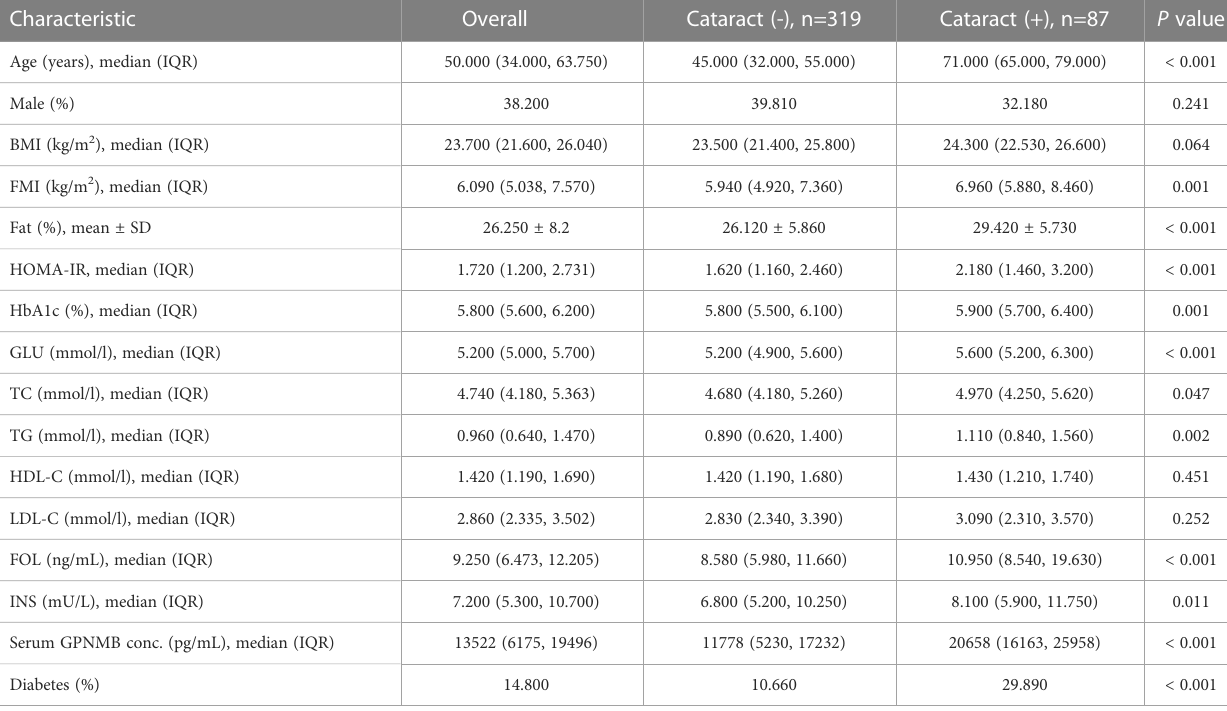
TABLE 2 Clinical and biochemical characteristics of study participants classi fi ed according to cataract. Characteristic